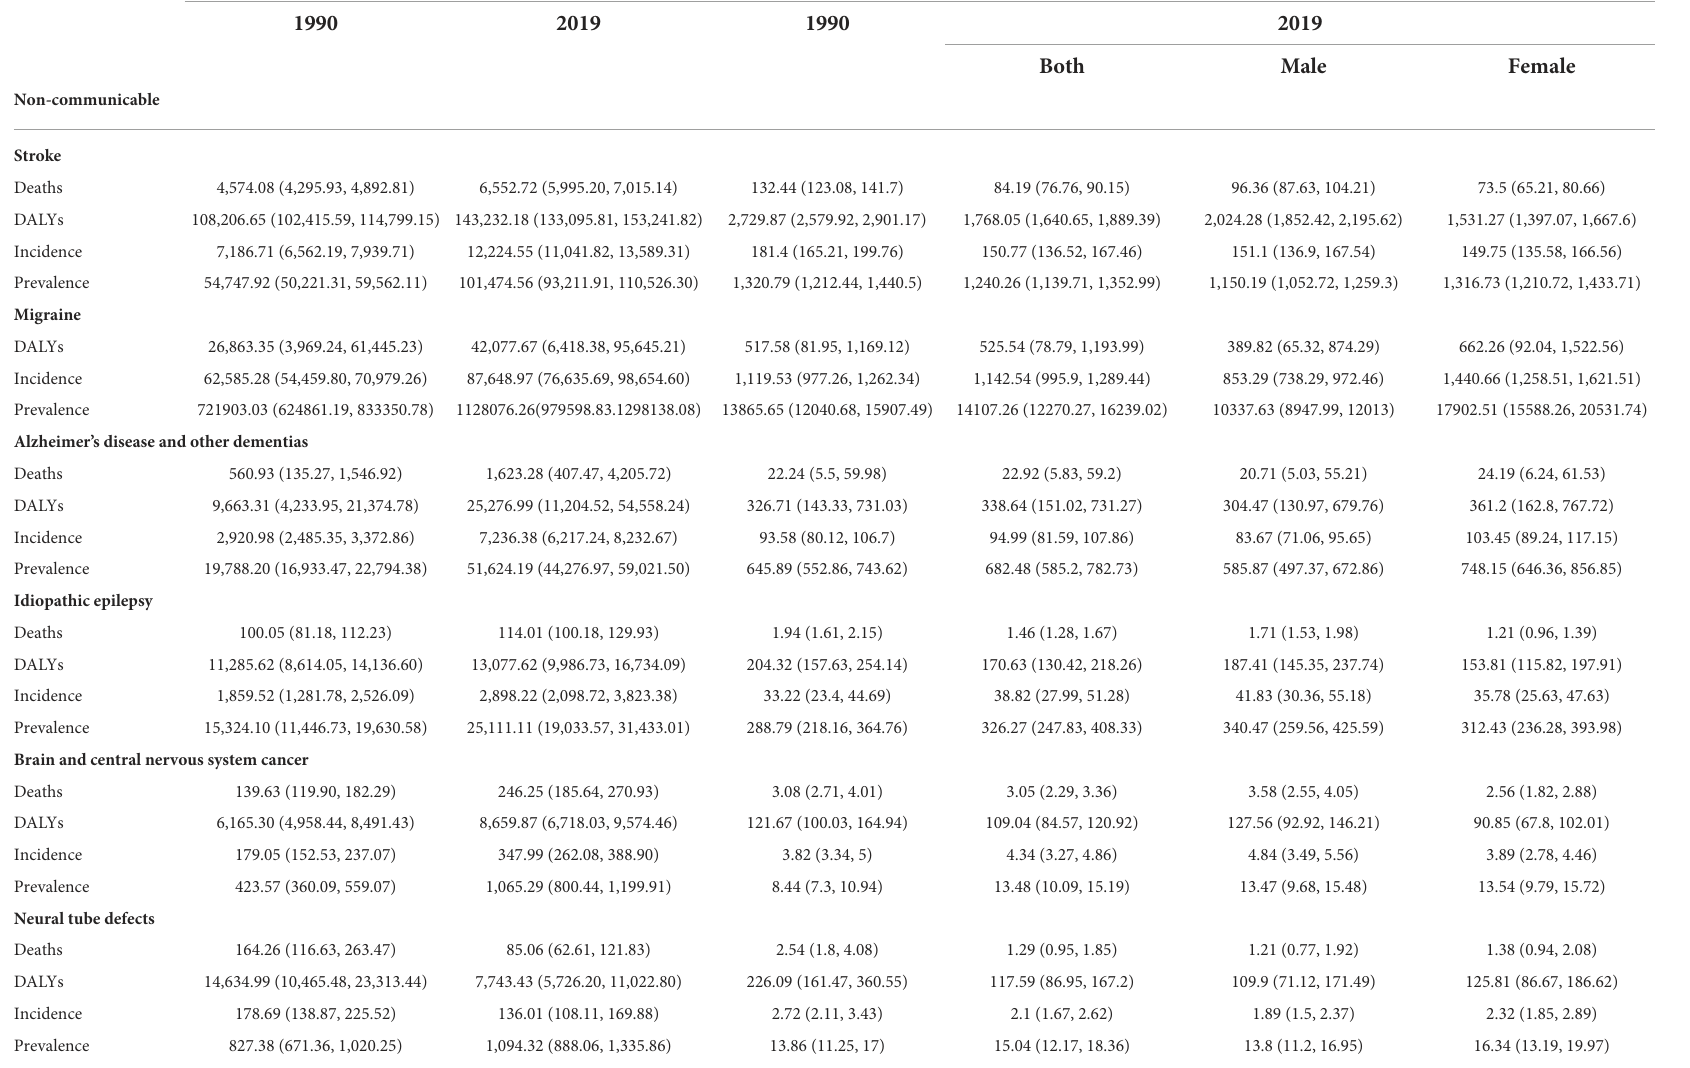
TABLE 1 Global deaths, DALYs, incidence, and prevalence and age-standardized rates by neurological disorders,